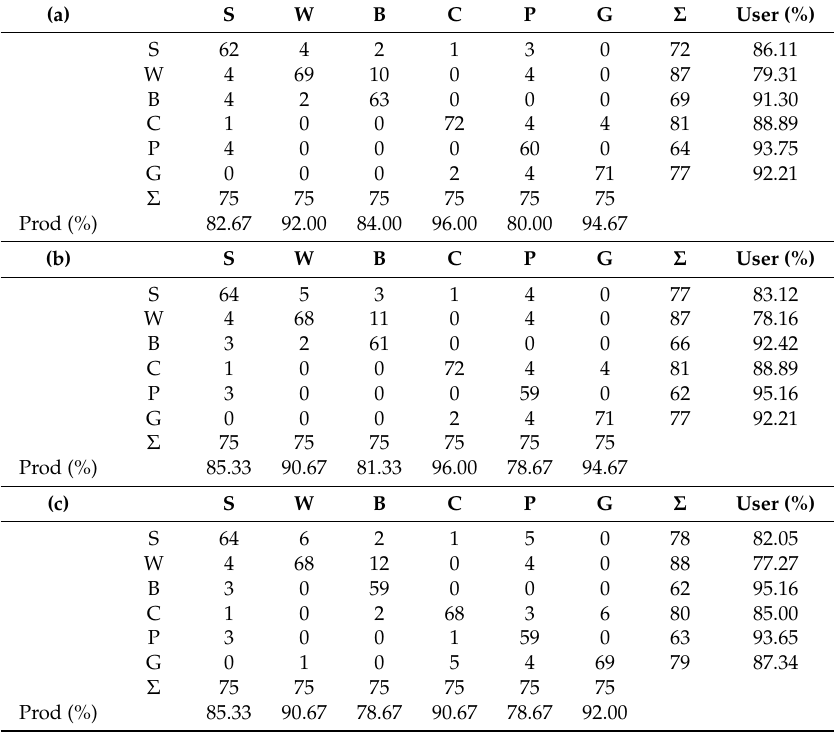
Table 9. Confusion matrices for classifications by the SMLR using training sets containing cases mislabelled to a randomly selected class: ( a ) 5% error; ( b ) 10% error; and ( c ) 20% error.